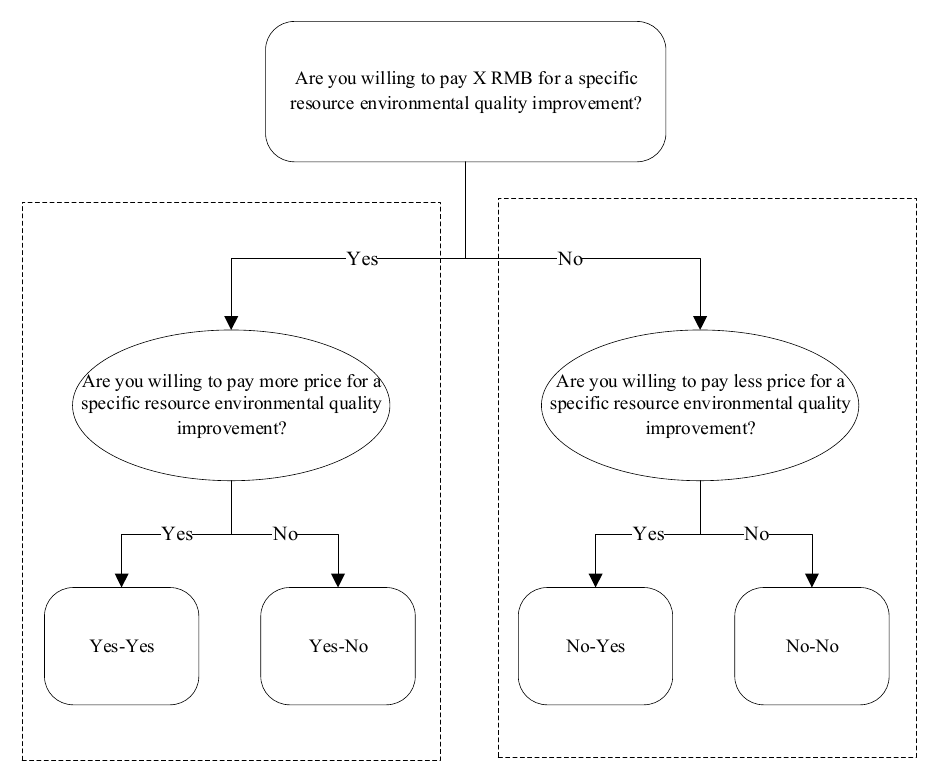
Figure 1. Flowchart of the double-bounded dichotomous CVM approach.